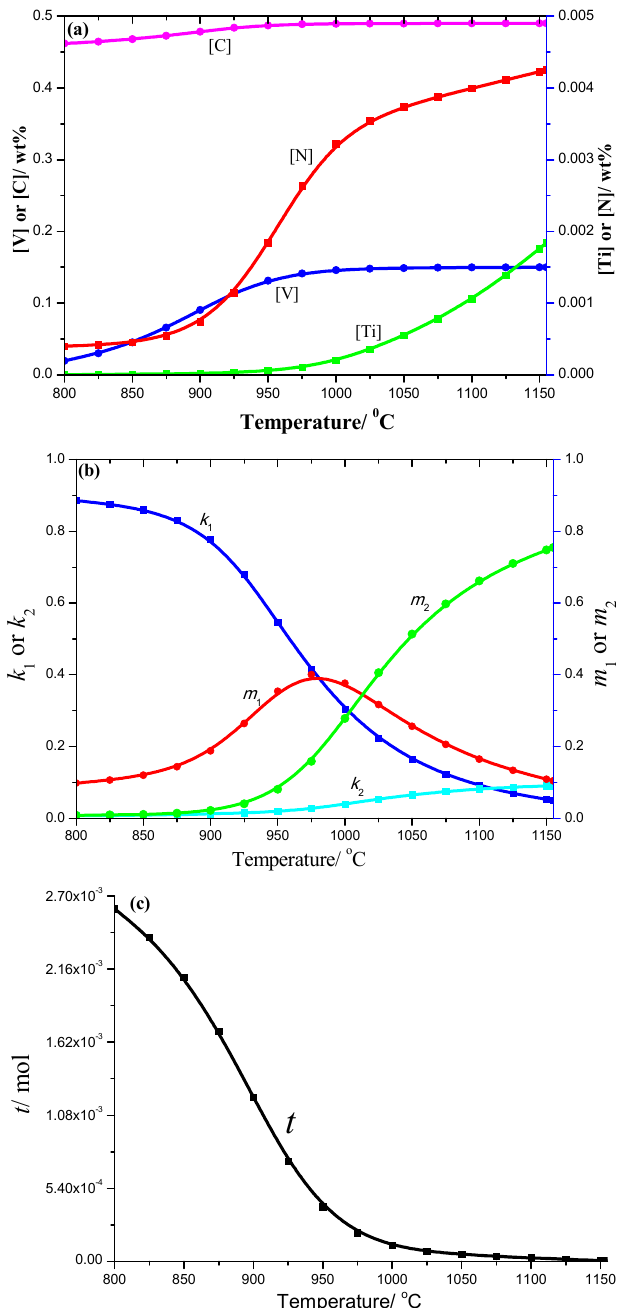
Figure 4. ( a ) Change of solid solution contents; ( b ) k 1 , k 2 , m 1 , m 2 constants and ( c ) total moles number of compounds with temperature obtained from thermodynamics analysis of 50CrVA-S2#.